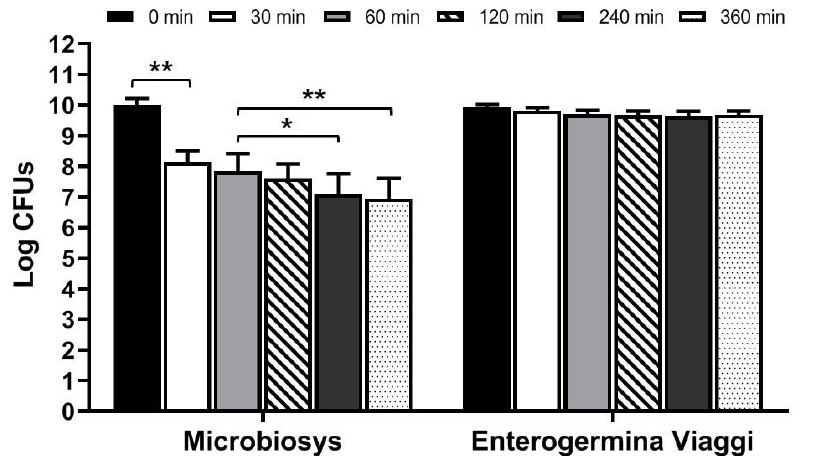
Figure 2. Behavior of microbes contained in Microbiosys and Enterogermina Viaggi in simulated intestinal juice (pH 8.0). Microbial counts were carried out at 0, 30, 60, 120, 240, and 360 min, and expressed as Log CFUs. * p < 0.05, ** p < 0.01.